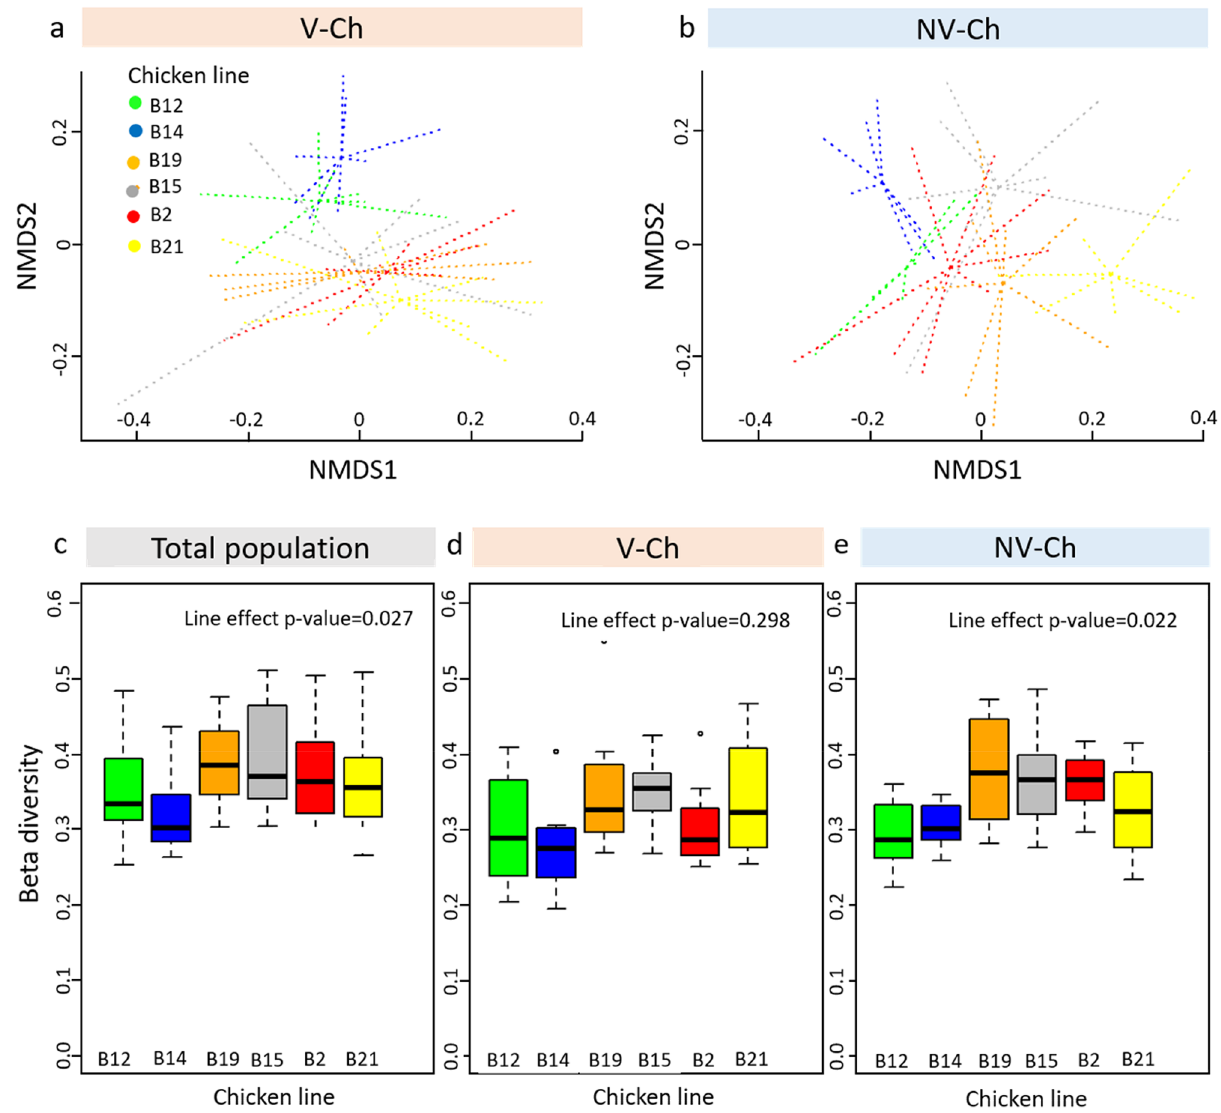
Figure 4. Association between the MHC line and the caecal microbial beta-diversity in laying hens one week after their infection with IBV. NMDS representation of the caecal microbial communities using Bray–Curtis distances among the different MHC lines in the ( a ) vaccinated and challenged (V-Ch, n = 48) and in the ( b ) non- vaccinated and challenged (NV-Ch, n = 45) groups. Representation of the community dispersion in each MHC- line through its β-diversity among ( c ) the total population, ( d ) the vaccinated challenged (V-Ch) group, and ( e ) the non-vaccinated challenged (NV-Ch) group. We indicated the p-value of the line effect. Asterisks indicate a significant difference between two lines based on post-hoc